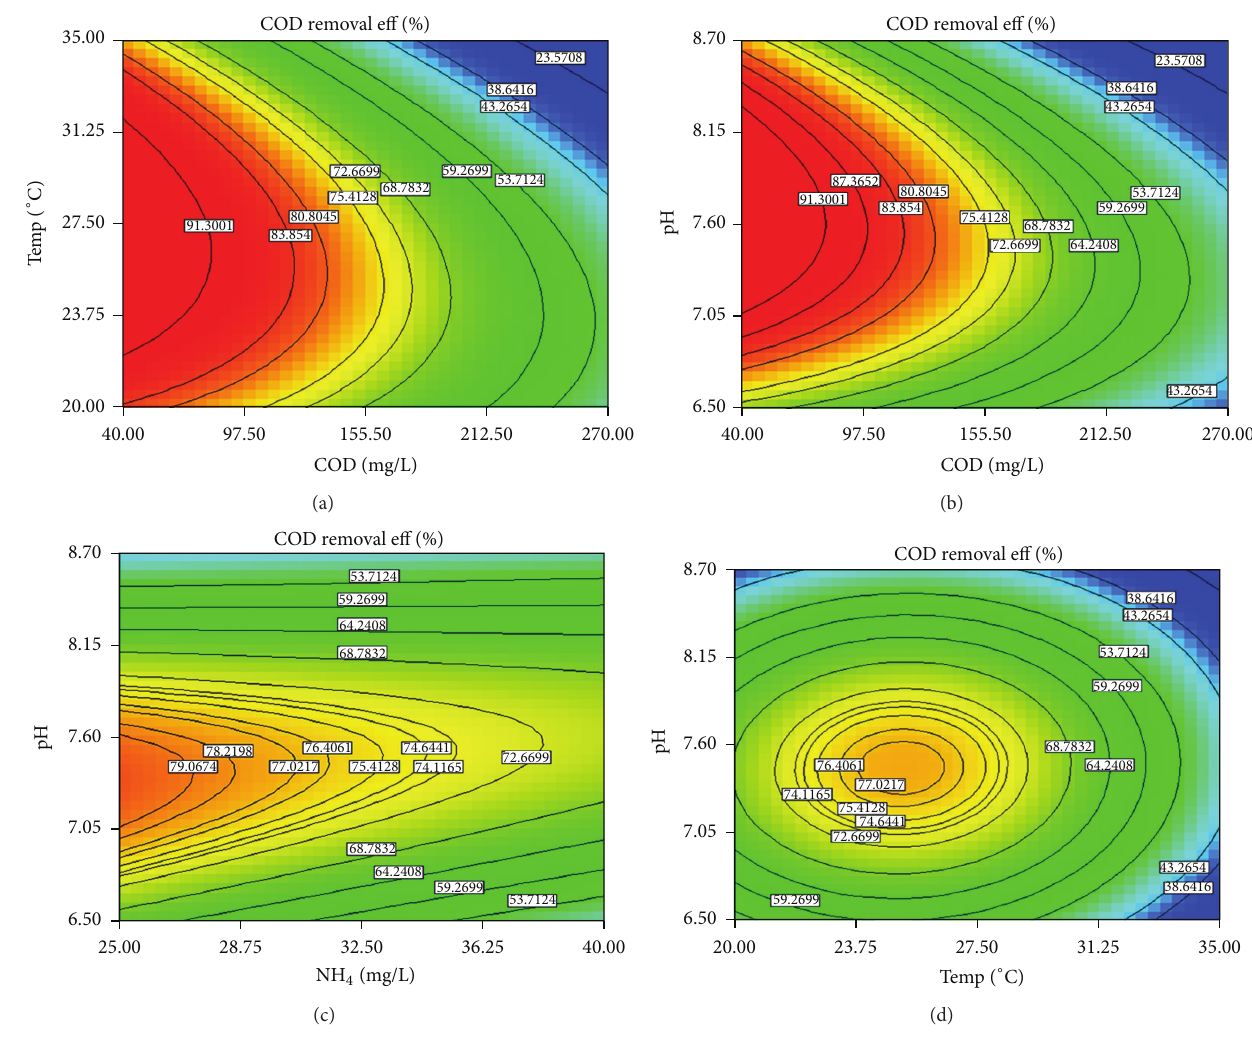
Figure 5: Contour diagram of natural variables for COD removal efficiency.